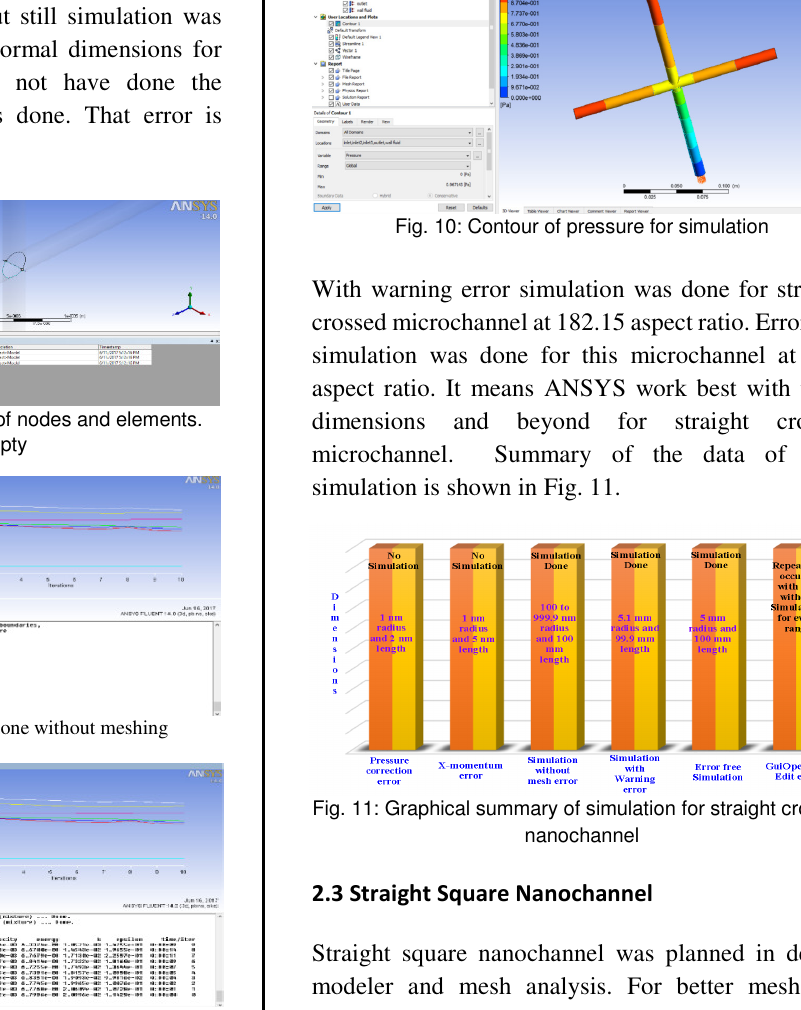
Fig. 9(c): Iterations were done